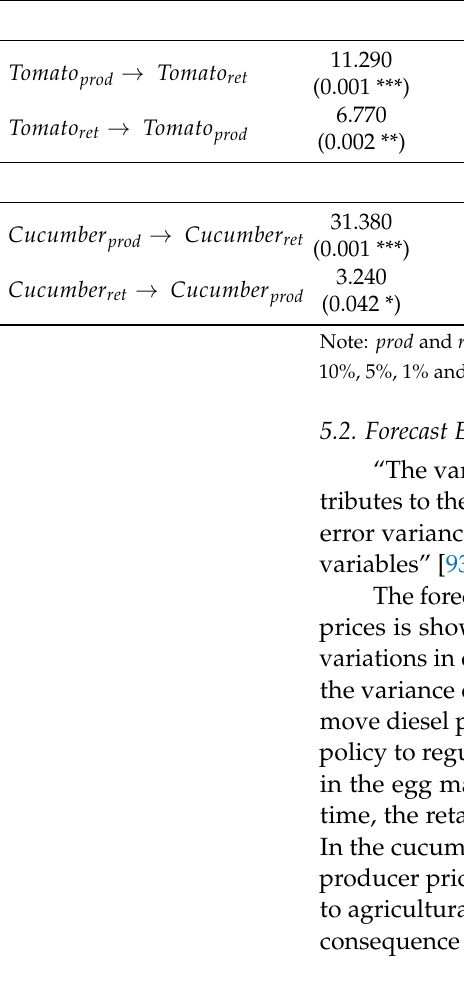
Table 8. Forecast error variance decomposition of agricultural commodity prices later 1